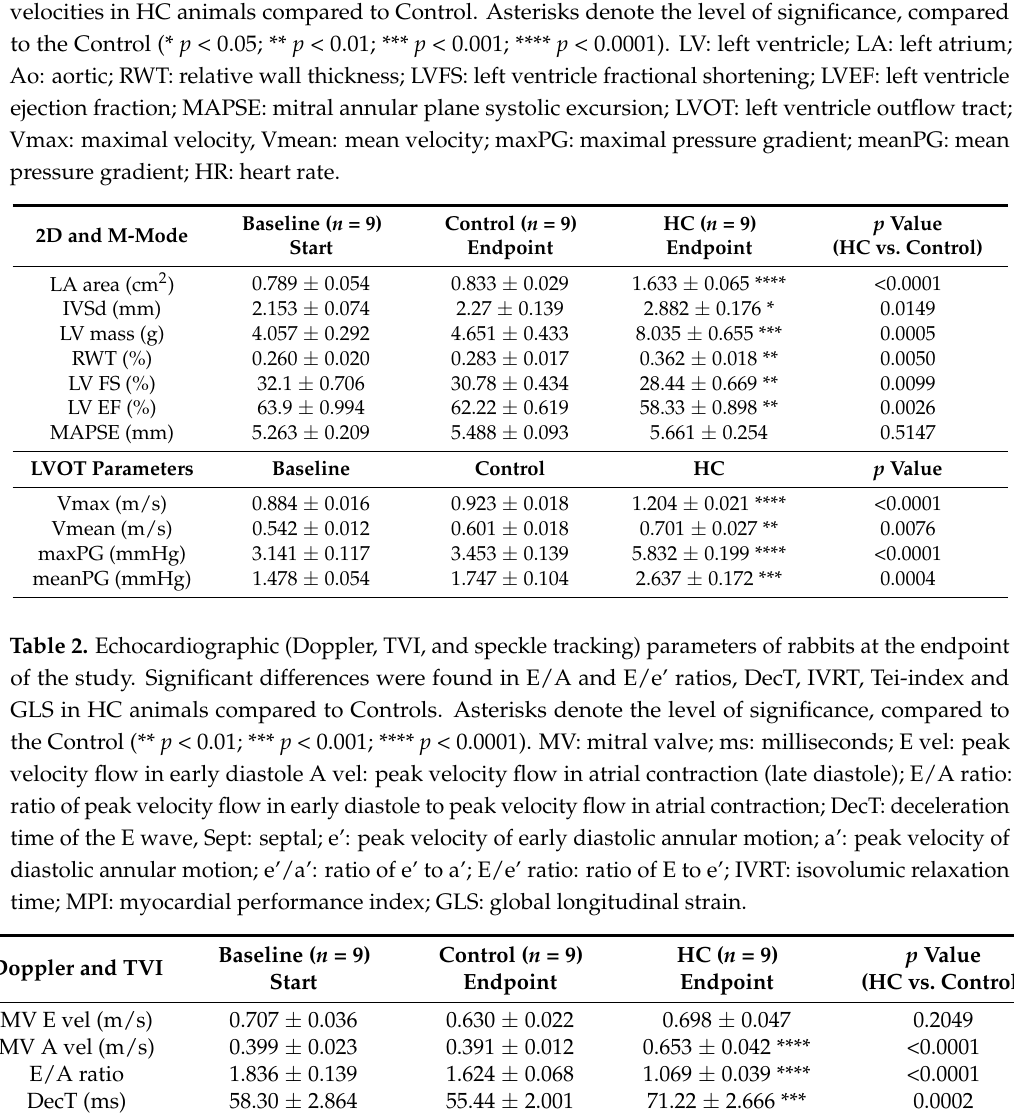
Table 1. Echocardiographic (2D, M-mode and LVOT) parameters of animals at the endpoint of the study. Significant differences were found in LA area, LV mass, RWT, as well in LVOT pressures and velocities in HC animals compared to Control. Asterisks denote the level of significance, compared to the Control (* p < 0.05; ** p < 0.01; *** p < 0.001; **** p < 0.0001). LV: left ventricle; LA: left atrium;